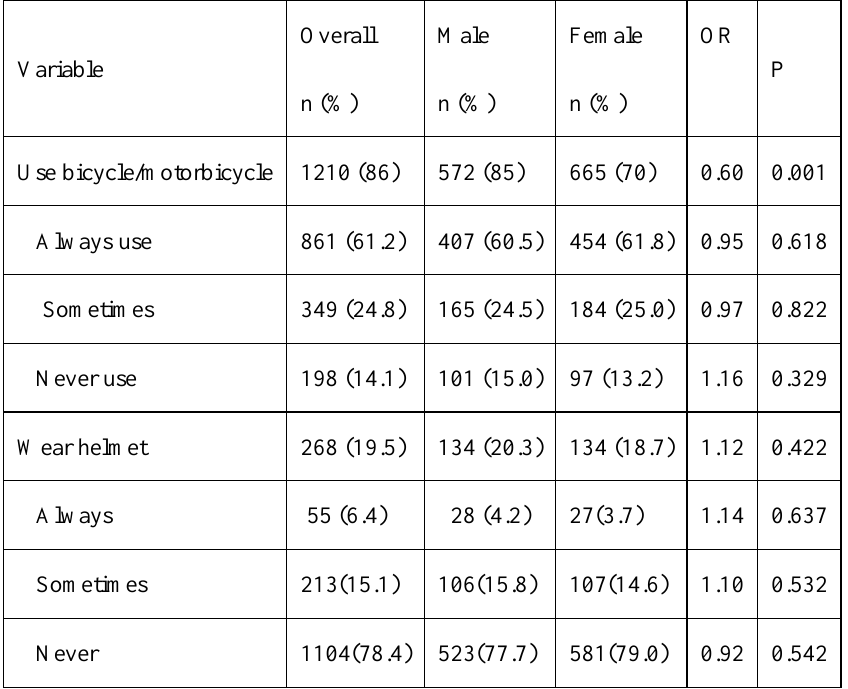
Variable Use bicycle/motorbicycle 1210 (86) 572 (85) 665 (70) 0.60 0.001